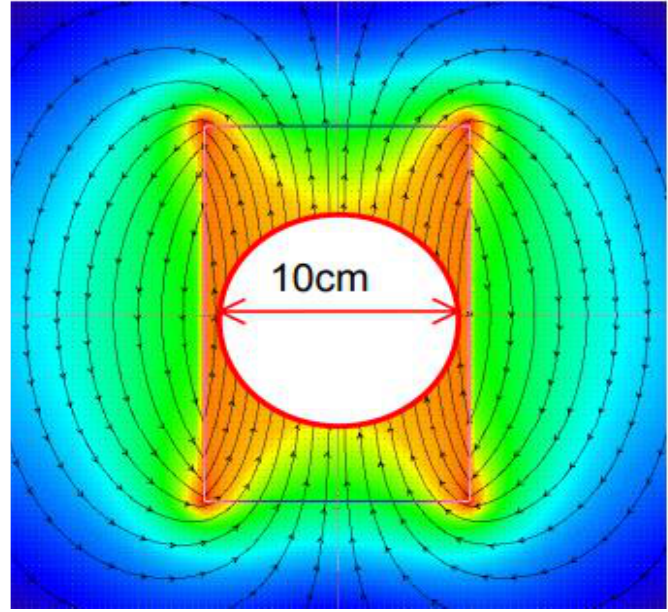
Figure 2. Distribution of the magnetic field in the coil.